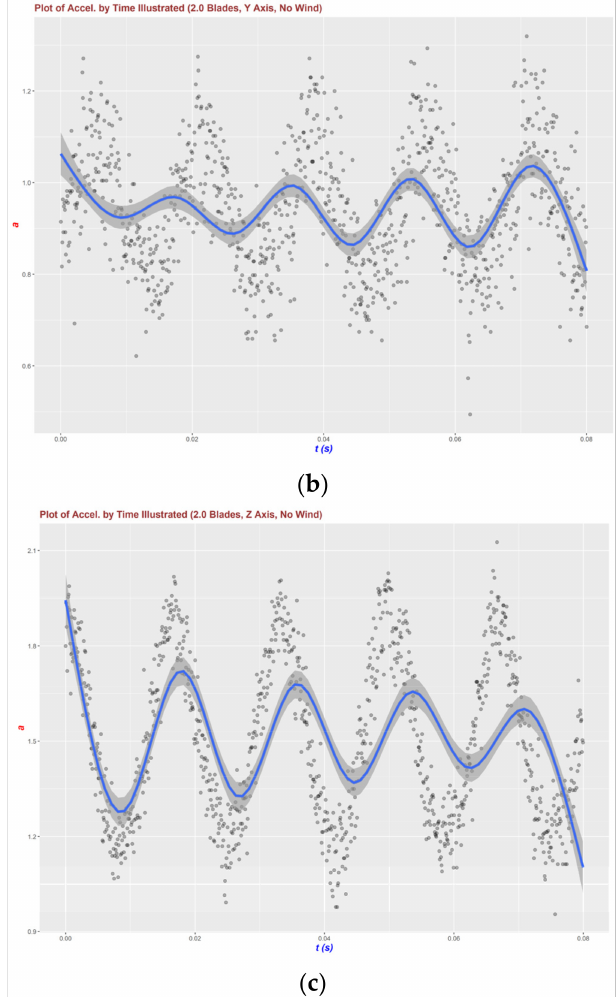
Figure 7. Magnitude and trend of acceleration for the 2.0-blade (one blade missing) turbine. ( a ) Based on datasets recorded along the X axis with no wind imposed. ( b ) Based on datasets recorded along the Y axis with no wind imposed. ( c ) Based on datasets recorded along the Z axis with no wind